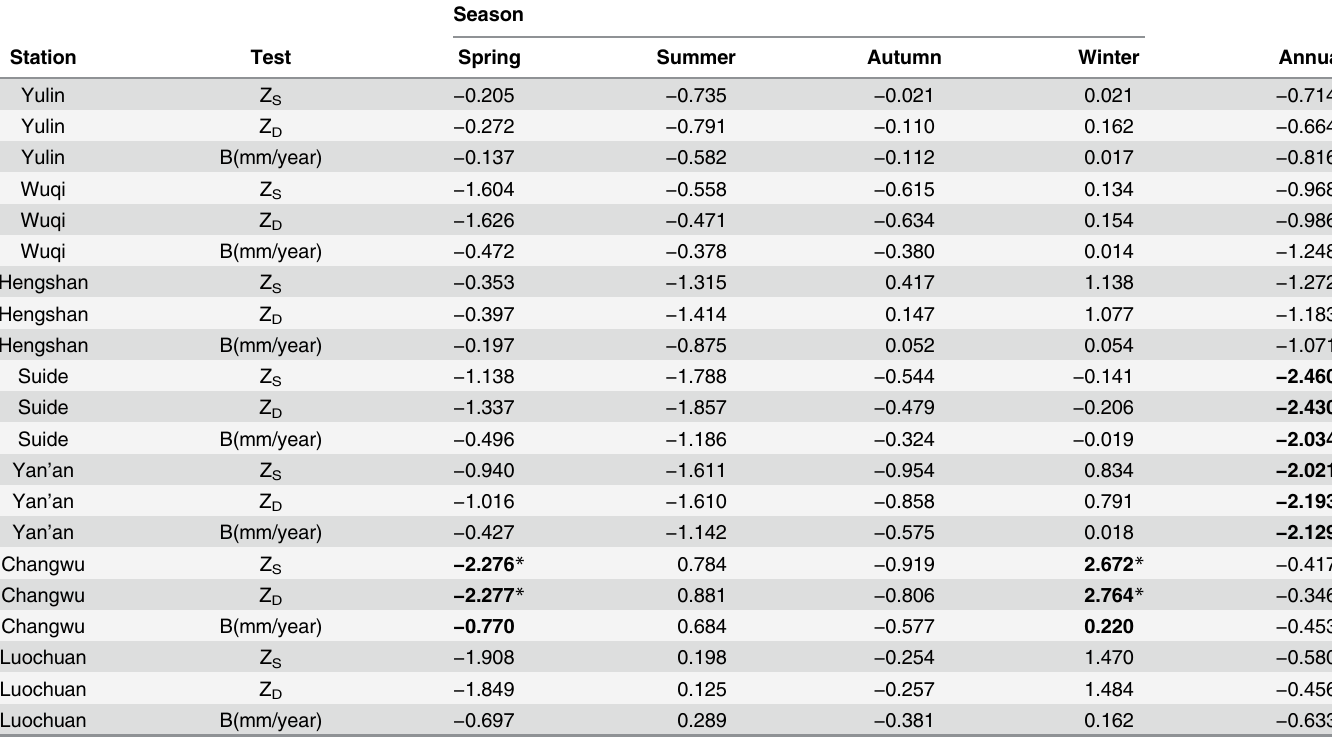
Analysis of different time scales of SPI. Fig 3 shows the SPI (SPI-1, SPI-3, SPI-6, SPI-12) of different time scales at the Yulin, Suide and Luochuan synoptic stations (3 representative synoptic stations from north to south) during 1957 – 2012. The SPI on shorter time scales (say 1 and 3 months) was frequent fluctuations around the horizontal axis and affected by short time precipitation. While on the longer time scales (6 and 12 months), the responses of SPI-6 and Table 7. Results of the statistical tests for seasonal and annual precipitation during 1957 –